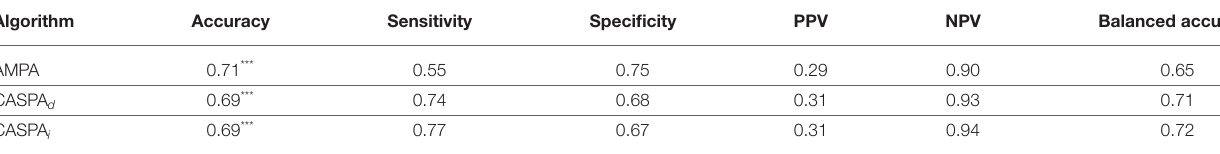
TABLE 2 | Detailed results of SDA-M-based error prediction in the Kanku-dai sequence. Algorithm